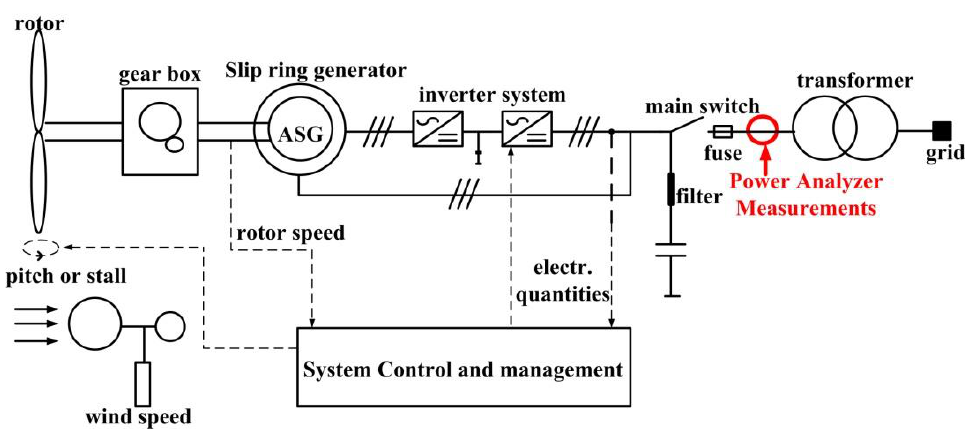
Figure 2. Architecture and measurement point of the wind turbine.